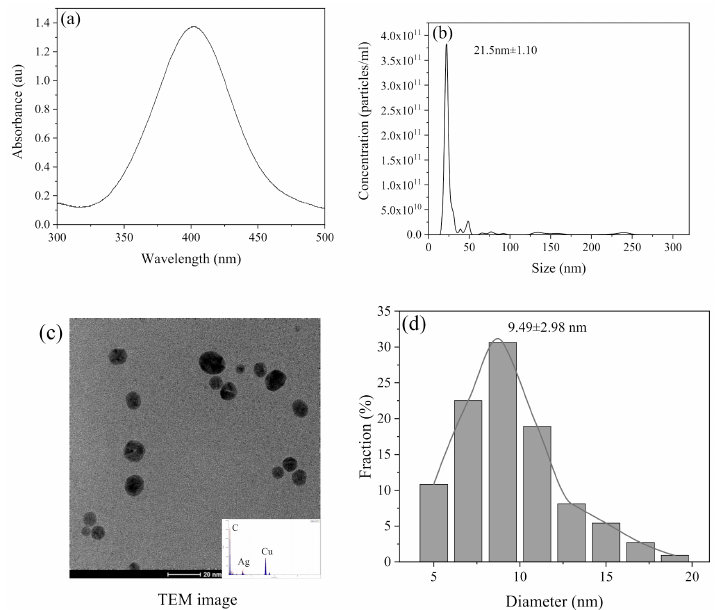
Figure 1. The physico–chemical properties of synthesized cit–AgNPs, such as absorption spectra measured by UV–vis ( a ), hydrodynamic size distribution measured by NTA ( b ), TEM image with EDX ( c ), and dry size obtained by TEM image analysis ( d